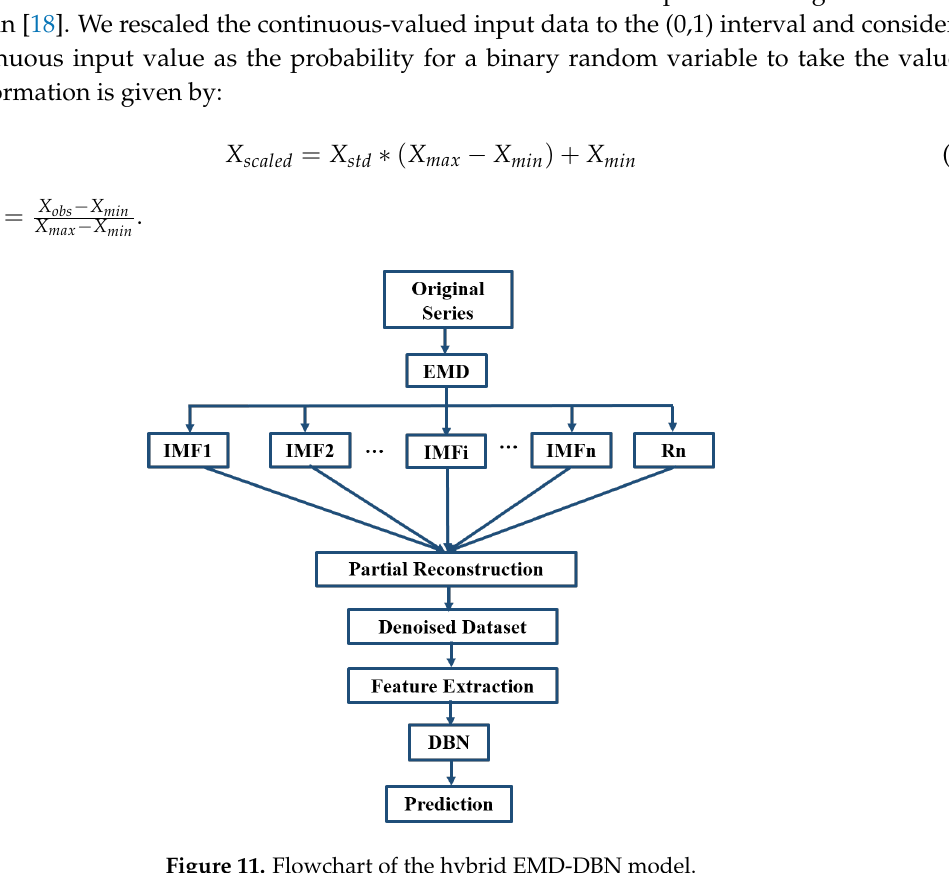
Figure 11. Flowchart of the hybrid EMD-DBN